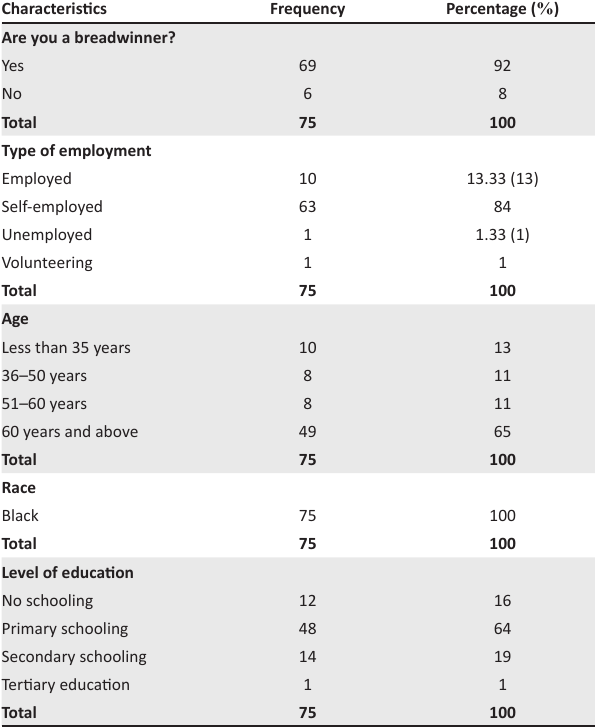
TABLE 1: Demographic and socioeconomic characteristics of female farmers in Thaba Chweu Local Municipality.